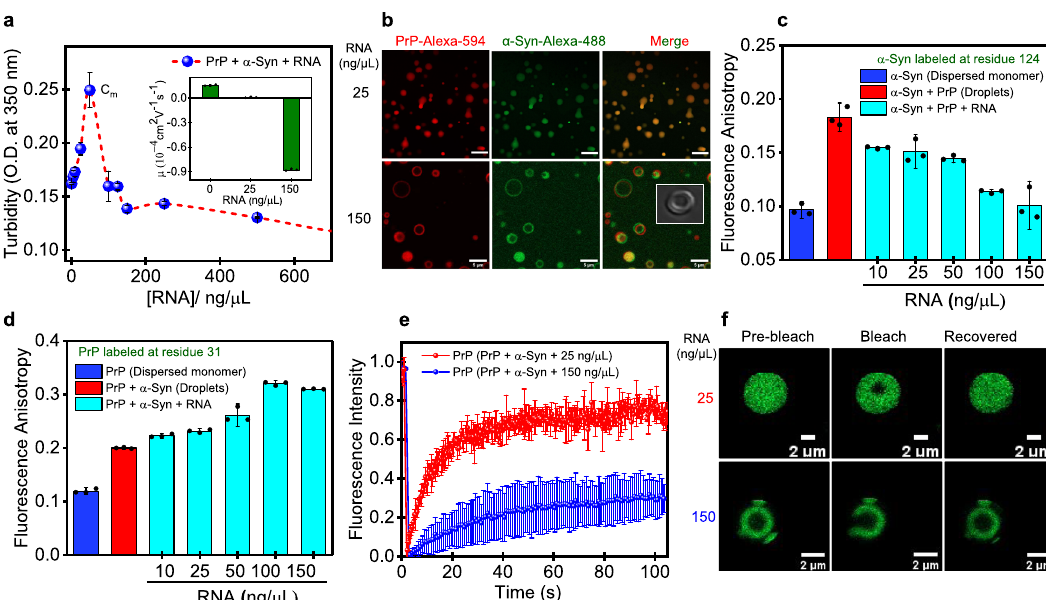
Fig. 4 RNA participates in a competitive multicomponent coacervation. a Solution turbidity plot as a function of increasing polyU RNA at a fi xed α - Syn:PrP ratio showing a reentrant phase behavior. The inset shows charge inversion at different RNA concentrations. The data represent mean ± s.d. for n = 3 independent experiments (corresponding data points are shown as black dot plots) b Confocal fl uorescence images for different regions of the phase diagram with RNA concentrations as indicated. Before the maximum (C m ), the ternary complex exhibits miscibility, whereas, beyond the maximum (C m ), the droplets start dispersing by transitioning into multiphasic, vesicle-like, hollow condensates. The imaging was performed thrice with similar observations. Top panel: PrP (20 µ M) + α -Syn (30 µ M) + RNA (25 ng/ µ L). Scale bar: 10 µ m. Bottom panel: PrP (60 µ M) + α -Syn (90 µ M) + RNA (150 ng/ µ L). Scale bar: 5 µ m. The inset shows a DIC image for a single hollow condensate (Scale bar: 10 µ m). See Supplementary Movie 2 for hollow condensates. c Steady-state fl uorescence anisotropy for F5M-labeled α -Syn at residue 124 indicating its displacement from the condensates with increasing RNA concentrations. The data represent mean ± s.d. for n = 3 independent experiments (corresponding data points are shown as black dot plots). d Steady-state fl uorescence anisotropy for F5M-labeled PrP residue 31 indicating an increase in the order within hollow condensates with the increase in the RNA concentration. The data represent mean ± s.d. for n = 3 independent experiments (corresponding data points are shown as black dot plots). e FRAP kinetics of multiple droplets (~1% Alexa-488-labeled protein) for PrP at different RNA concentrations (25 ng/ µ L: blue; 150 ng/ µ L: red). The data represent mean ± s.d. for n = 3 independent experiments. f Fluorescence images of droplets during FRAP measurements. Source data are provided as a Source Data fi